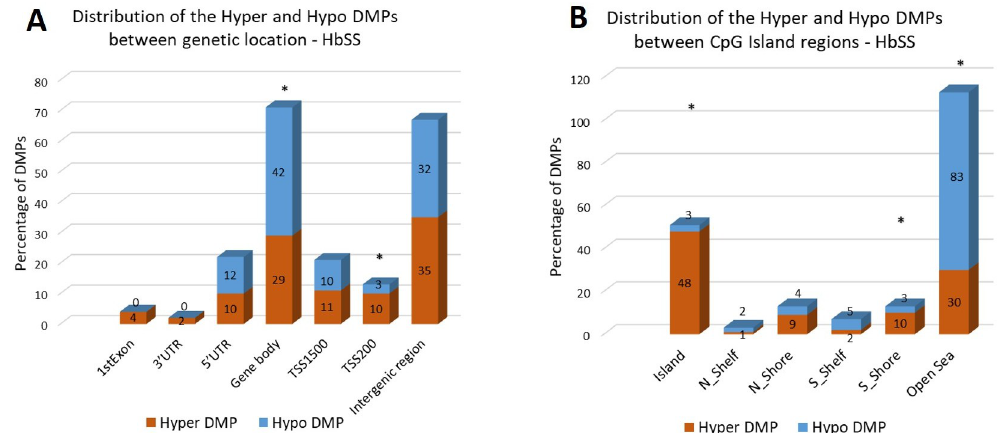
Fig 4. ( A ) The distribution of hyper DMPs and hypo DMPs according to their distance from the promoter. TSS1500 , 200 to 1500 base pairs upstream of the transcription start site (TSS); TSS200 , 200 base pairs upstream of the TSS; 5 0 UTR , 5 0 untranslated region; 1st Exon ; 3 0 UTR , 3 0 untranslated region. (B) The distribution of hyper DMPs and hypo DMPs in different genomic region types. Island , a CpG site located within a CpG island; Shore , a CpG site located < 2 kilobases from a CpG island (N_: located at North; S_: located at South); Shelf , a CpG site located > 2 kilobases from a CpG island; Open sea , a CpG site not in an island or annotated gene. Data of DMPs obtained from the comparison between HbSS vs Control groups. � : group of DMPs (hyper or hypomethylated) statistically more frequent in a specific region (p < 0.05; chi-square distribution test).